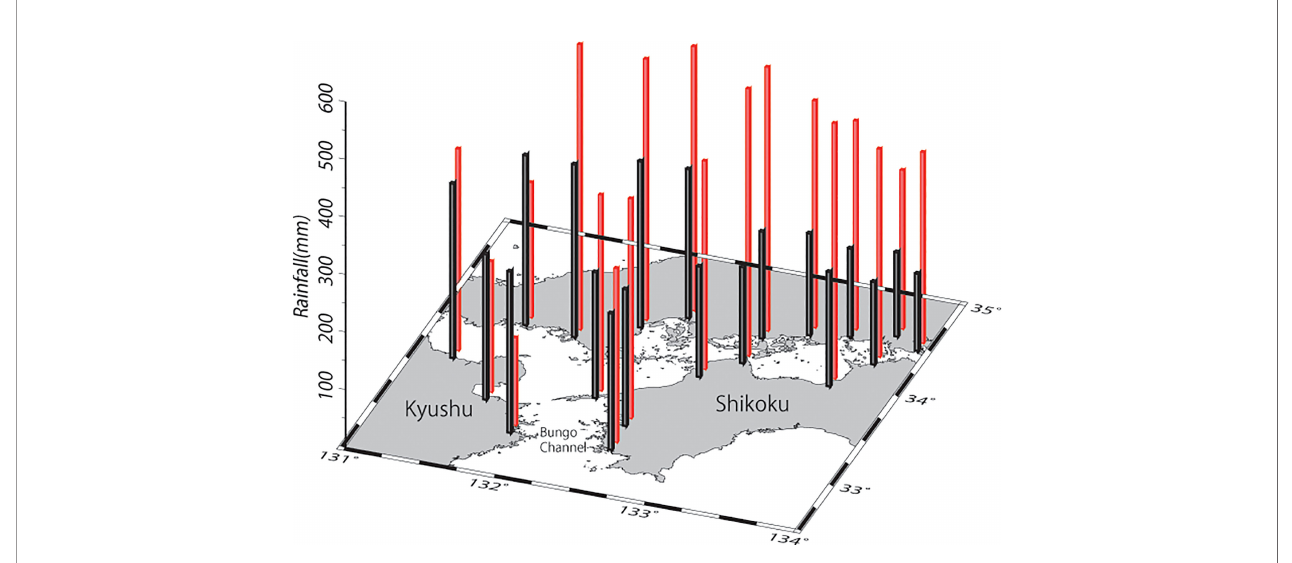
FIGURE 2 | Integrated precipitation for July 5 – 8, 2018 (red bars) and monthly integrated precipitation in July of a normal year (black bars) around the Seto Inland